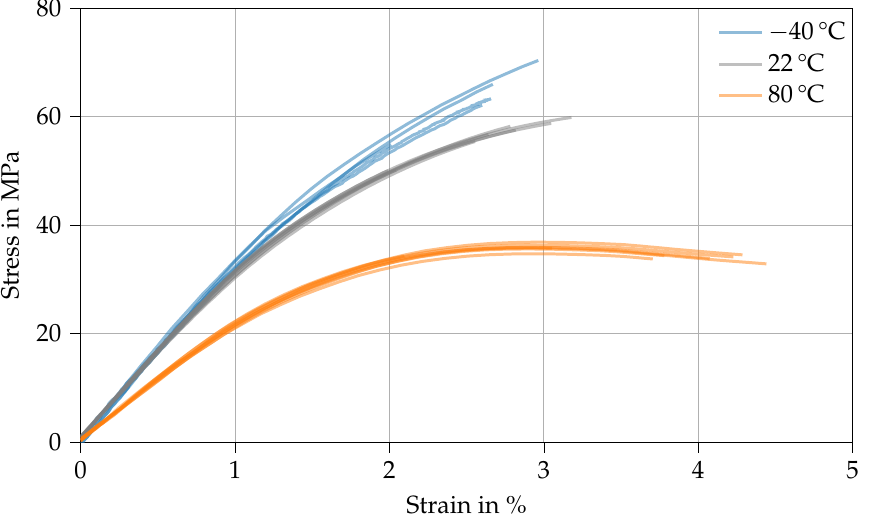
Figure 4. Stress–strain curves derived from tensile tests of Argopox at T = − 40°C (blue), 22°C (gray), and 80°C (orange).